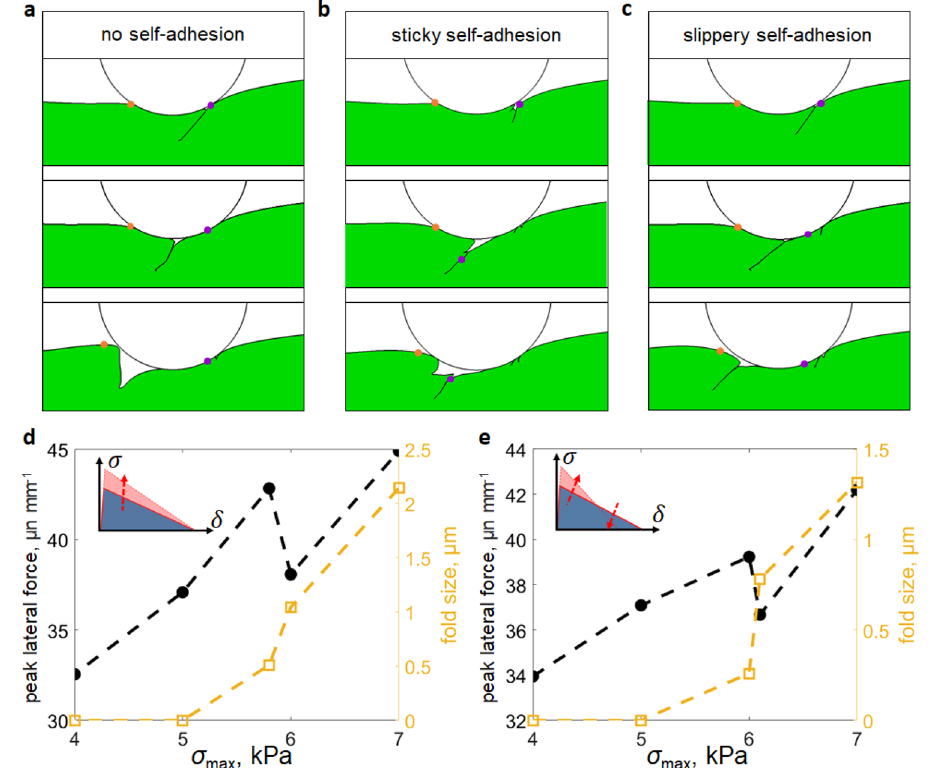
Fig. 5 | Effects of self-adhesion on the Schallamach-wave-like motion of a crease. a – c Simulation snapshots showing the motion of a crease under a no self- adhesion, b sticky self-adhesion and c slippery self-adhesion, as de fi ned in Sup- plementary Note 5. The orange and purple dots represent two material points originally located atthe leading front and trailing edge, respectively. The crease in c is Schallamach wave-like and does not open until passing through the contact